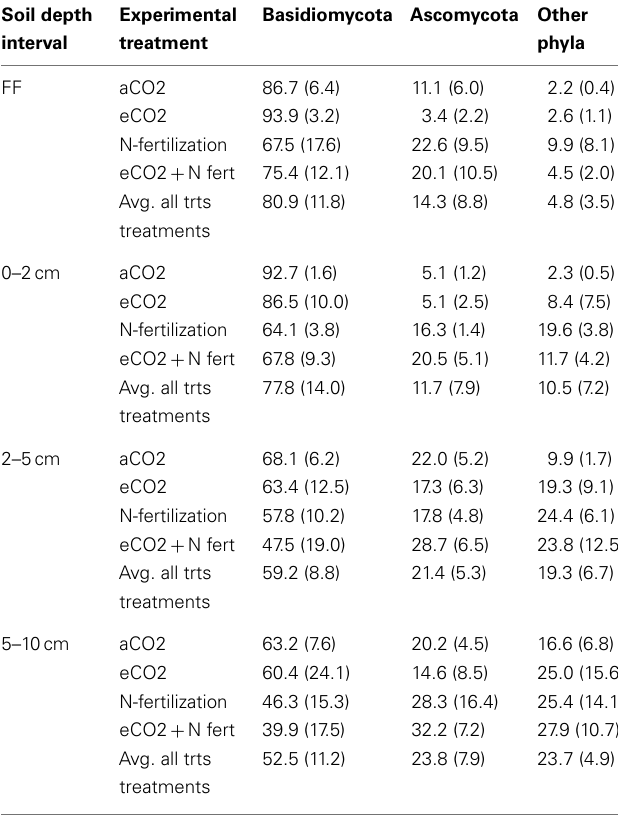
Table 4 | Proportion of Basidiomycota,Ascomycota, and Other Phyla in sequence libraries constructed from four soil depth intervals, in samples from each of four experimental